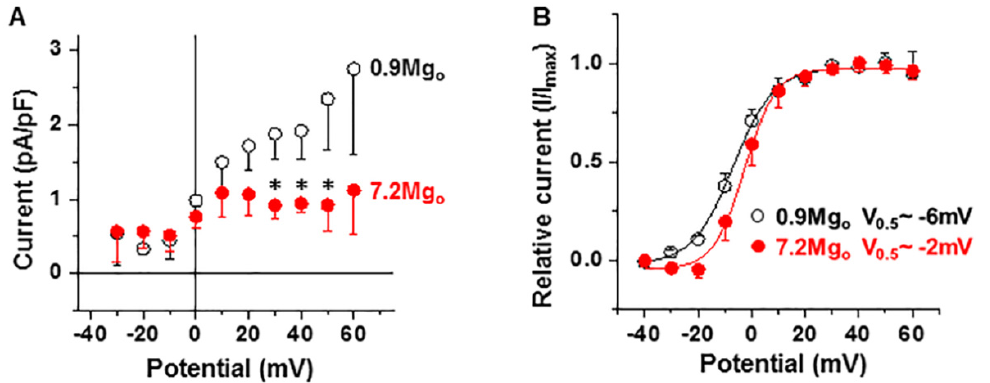
Figure 5. Effect of an increase of extracellular [Mg 2+ ] on the total I K . ( A ) The current–voltage relationship of the fully activated I K and the effect of raising the [Mg 2+ ] o . Notice the suppression of I K by high [Mg 2+ ] o . * p < 0.05 ( n = 4). ( B ) Activation curves of I K calculated from the tail currents ( n = 4).